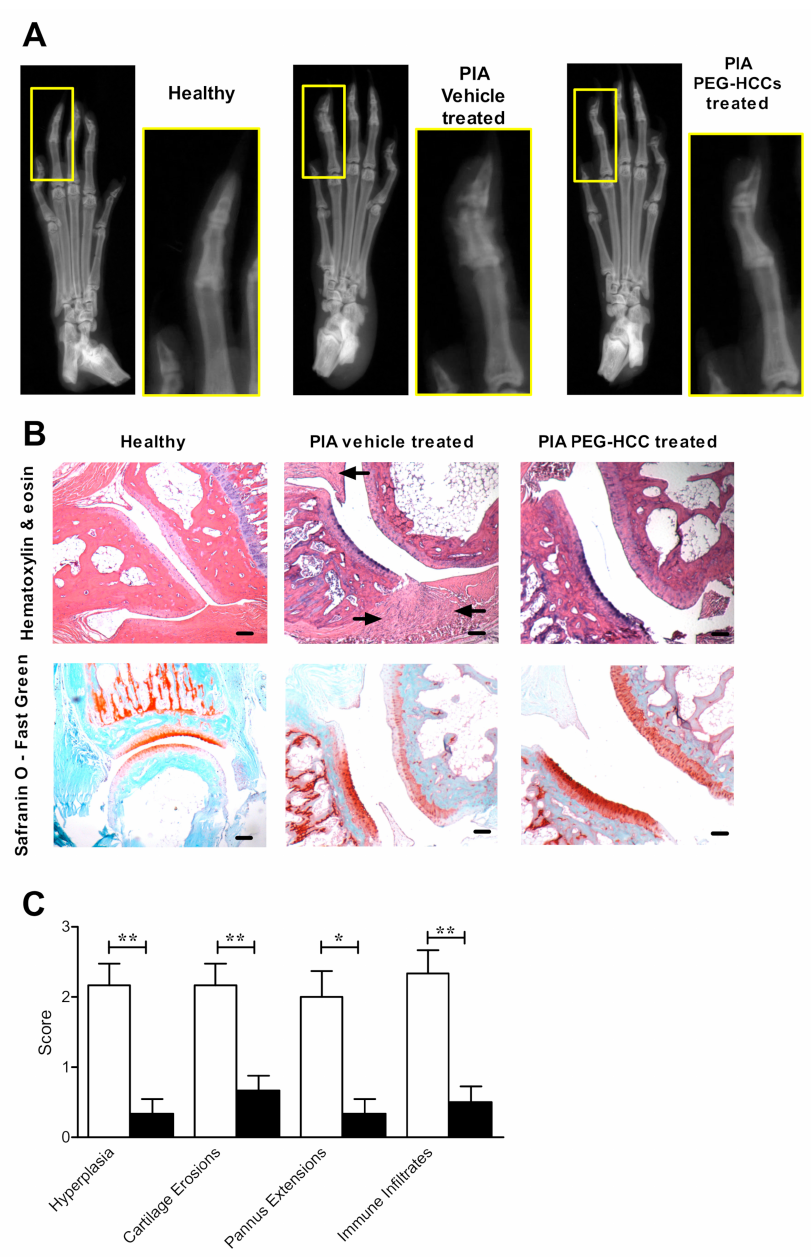
Figure 6. PEG-HCC-treated rats have reduced bone and synovial tissue destruction in PIA. ( A ) Example X-rays of the hind paws of a healthy rat, a vehicle-treated PIA rat, and a PEG-HCC-treated PIA rat. ( B ) Example images of hind paw joints of a healthy rat, a vehicle-treated PIA rat, and a PEG-HCC-treated PIA rat, stained with either hematoxylin & eosin (left) or safranin O-fast green (right). Arrows indicate areas of immune infiltrates in the synovium. Scale bar = 100 µ m. ( C ) Quantification of pathologic hallmarks of disease of the joints of PIA rats treated with vehicle (white bars, n = 6) or PEG-HCCs (black bars, n = 6), as determined through analysis of hematoxylin & eosin and safranin O-fast green-stained joint sections. * p < 0.05, ** p < 0.001. Data are presented as mean ±